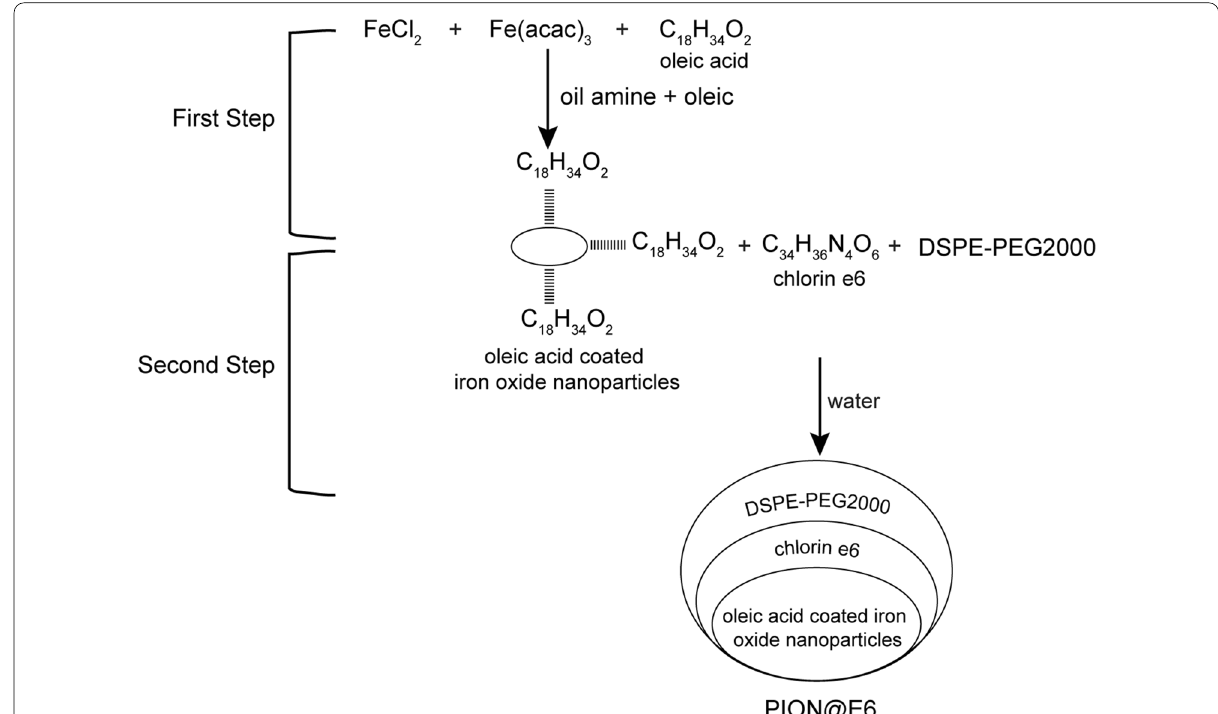
Fig. 1 Two steps for synthesis of USIONPs(PION@E6). DSPE-PEG2000, 1,2-distearoyl-sn-glycero-3-phosphoethanolamine-N-[amino- (PEG)-2000];